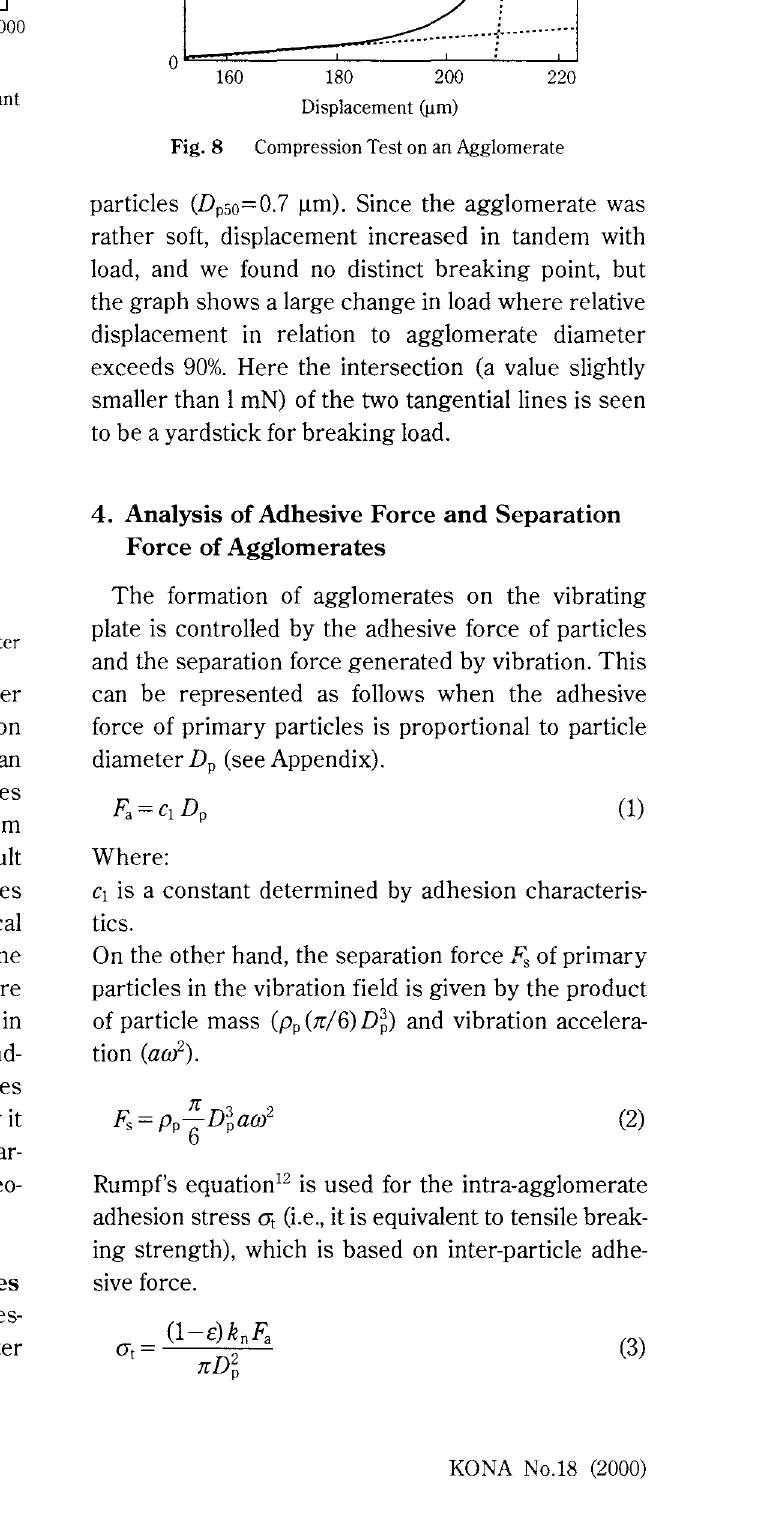
Cumulative Size Distribution of Agglomerates on Count Basis Plotted on a Log-Normal Scale